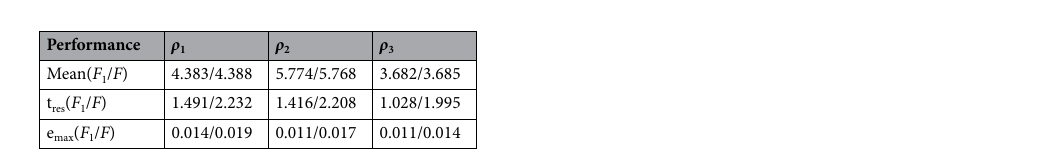
Table 4. Fault tolerance tracking